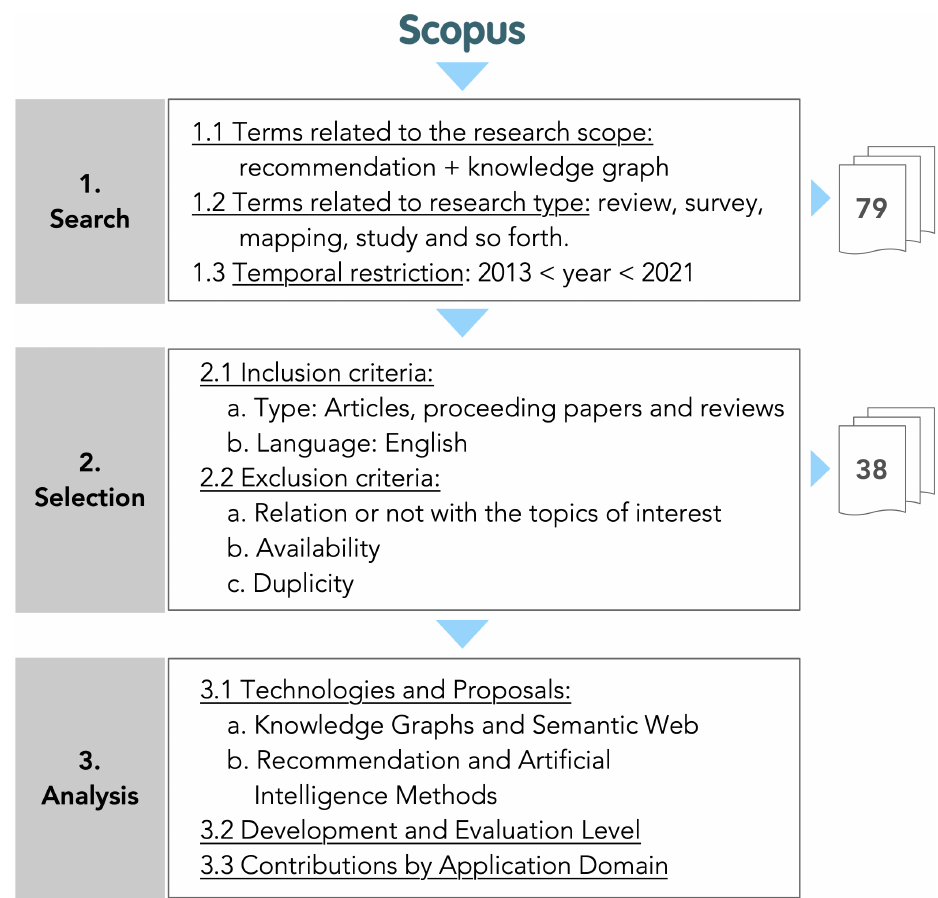
Figure 1. Methodology: stages and tasks carried on to search, select, and analyze the related